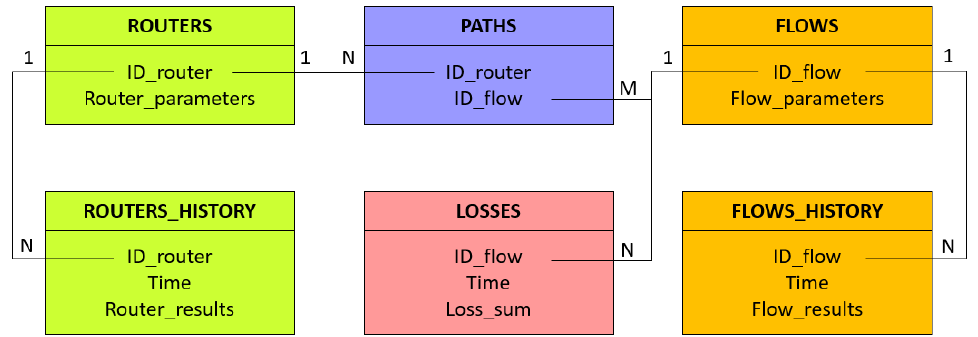
Figure 1. Database schema for numerical